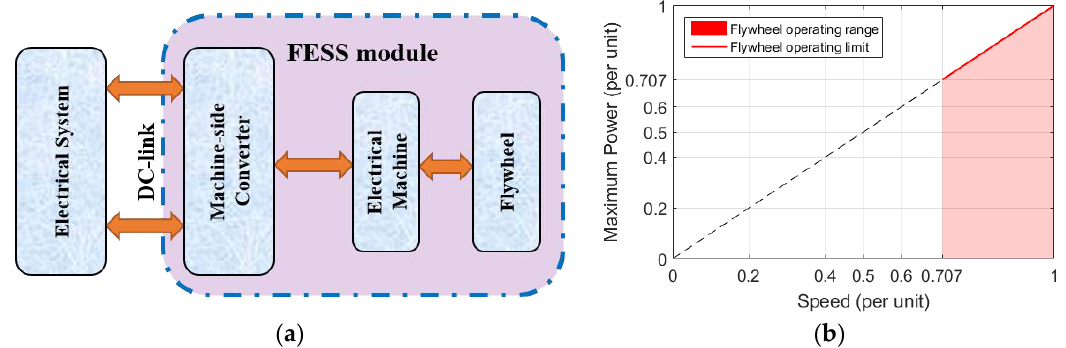
Figure 2. ( a ) Basic layout of the flywheel energy storage system (FESS) module connecting to a generic electrical system through a DC link; ( b ) Maximum power per unit as a function of speed.